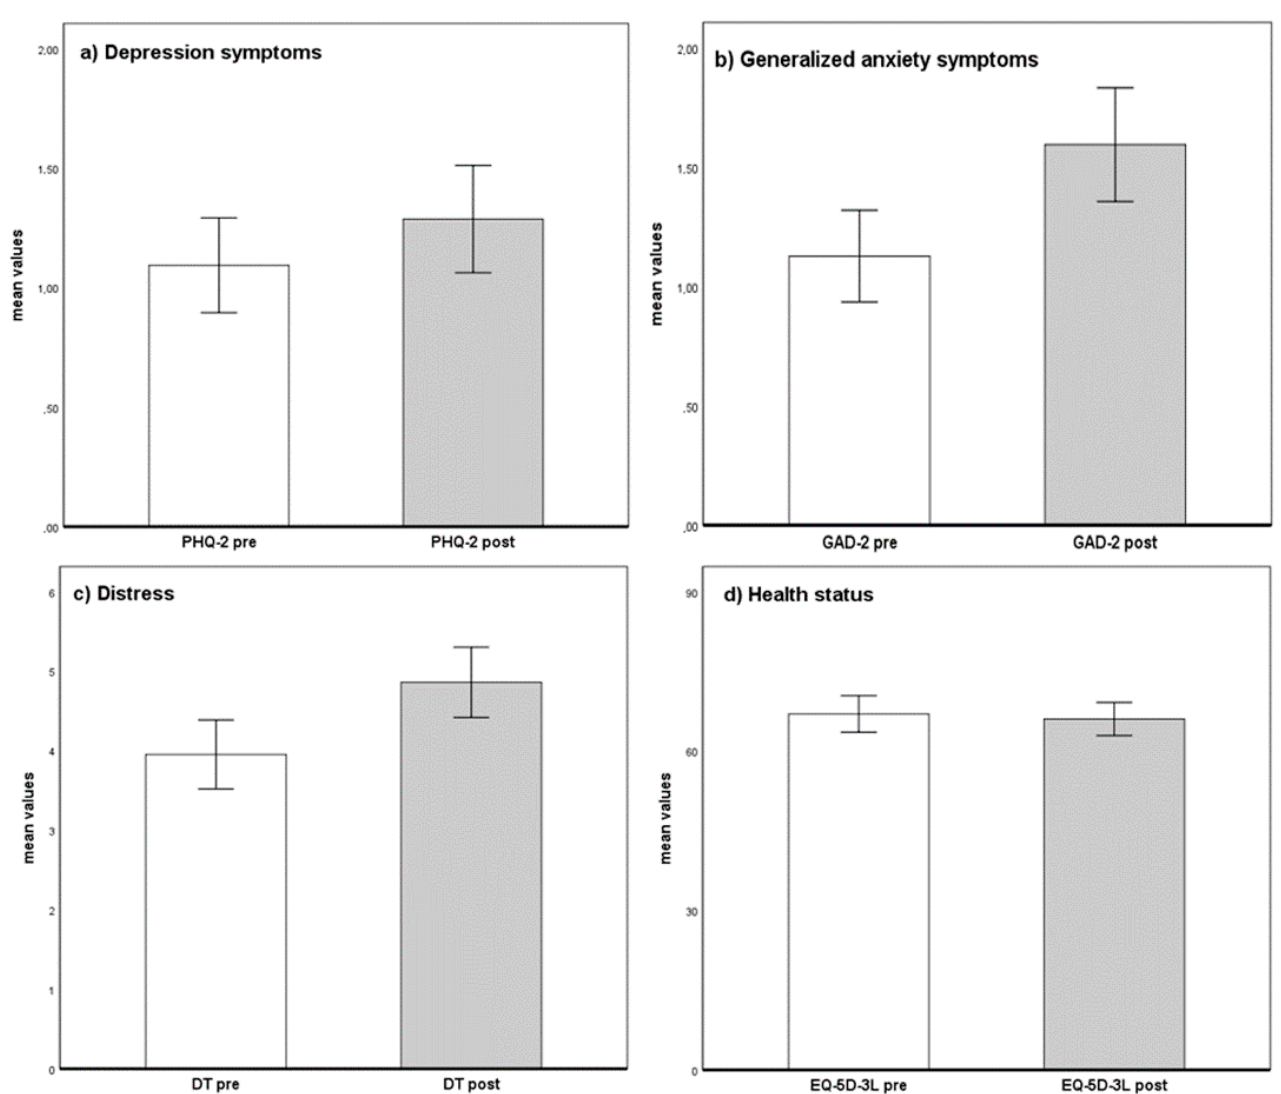
Figure 1. Mental health and health status mean scores before and after the COVID ‐ 19 outbreak. Mean values and 95% CI as error bars before (pre) and after (post) the COVID ‐ 19 outbreak of PHQ ‐ 2: Patient Health Questionnaire ‐ 2, M PHQ ‐ 2 pre = 0.91 vs. M PHQ ‐ 2 post = 1.14 ( a ); GAD ‐ 2: Generalized Anxiety Disorder Scale ‐ 2, M GAD ‐ 2 pre = 1.06 vs. M GAD ‐ 2 post = 1.52 ( b ); DT: Distress Thermometer M DT pre = 3.91 vs. M DT post = 4.94 ( c ); EQ ‐ 5D ‐ 3L: European Quality of Life 5 Dimensions 3 Level, M EQ ‐ 5D ‐ 3L pre = 82.32 vs. M EQ ‐ 5D ‐ 3L post = 80.27 ( d ).